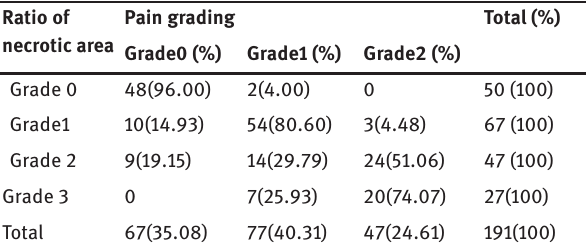
Table 3: Quantitative distribution of hip pain grades in various ratios of necrotic